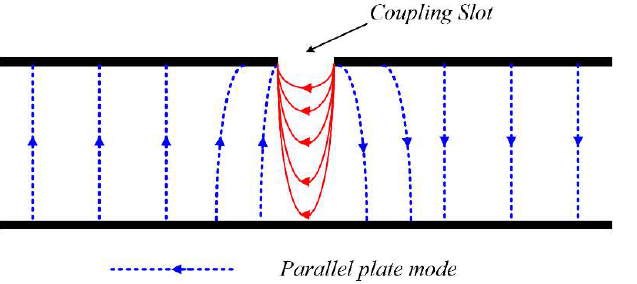
Figure 5. Parallel plate waveguide developed from the ground planes of the stripline of element antenna.